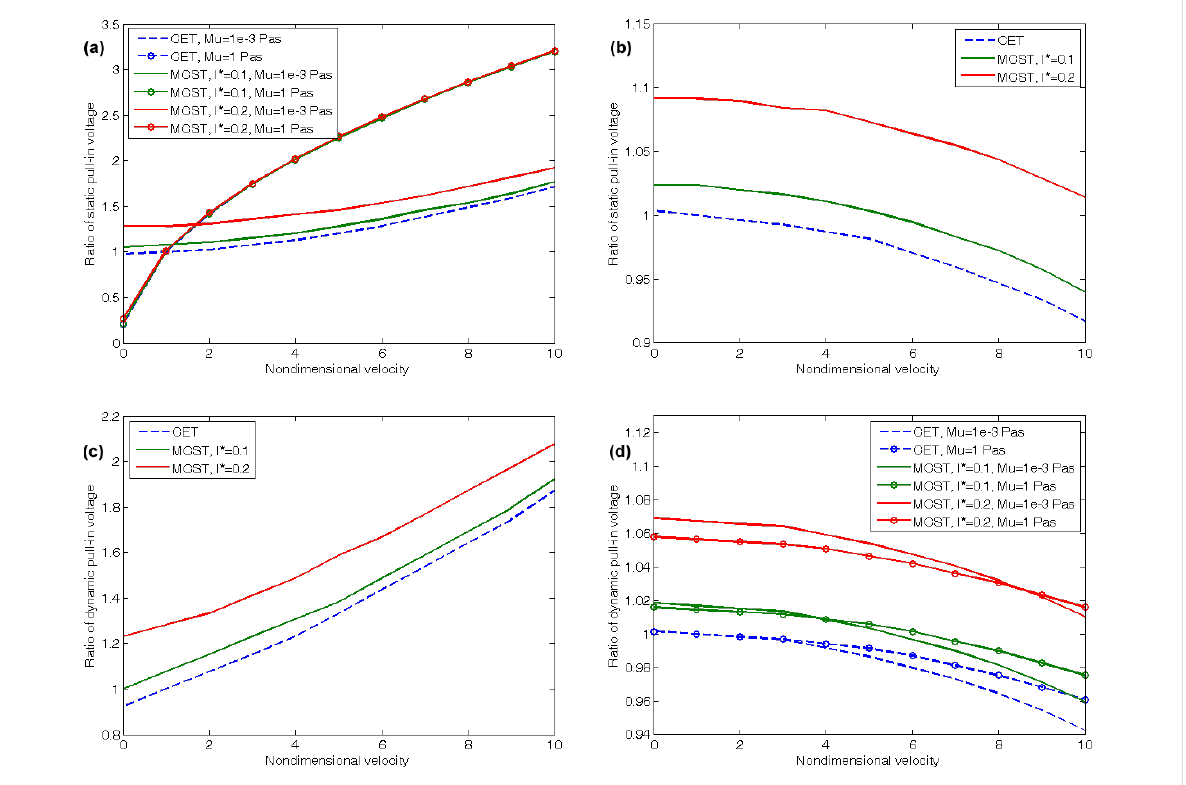
Figure 7: Effects of the fluid velocity on (a) the static pull-in voltage of cantilever CNT, (b) the static pull-in voltage of doubly clamped CNT, (c) the dynamic pull-in voltage of cantilever CNT, (d) the dynamic pull-in voltage of doubly clamped CNT.